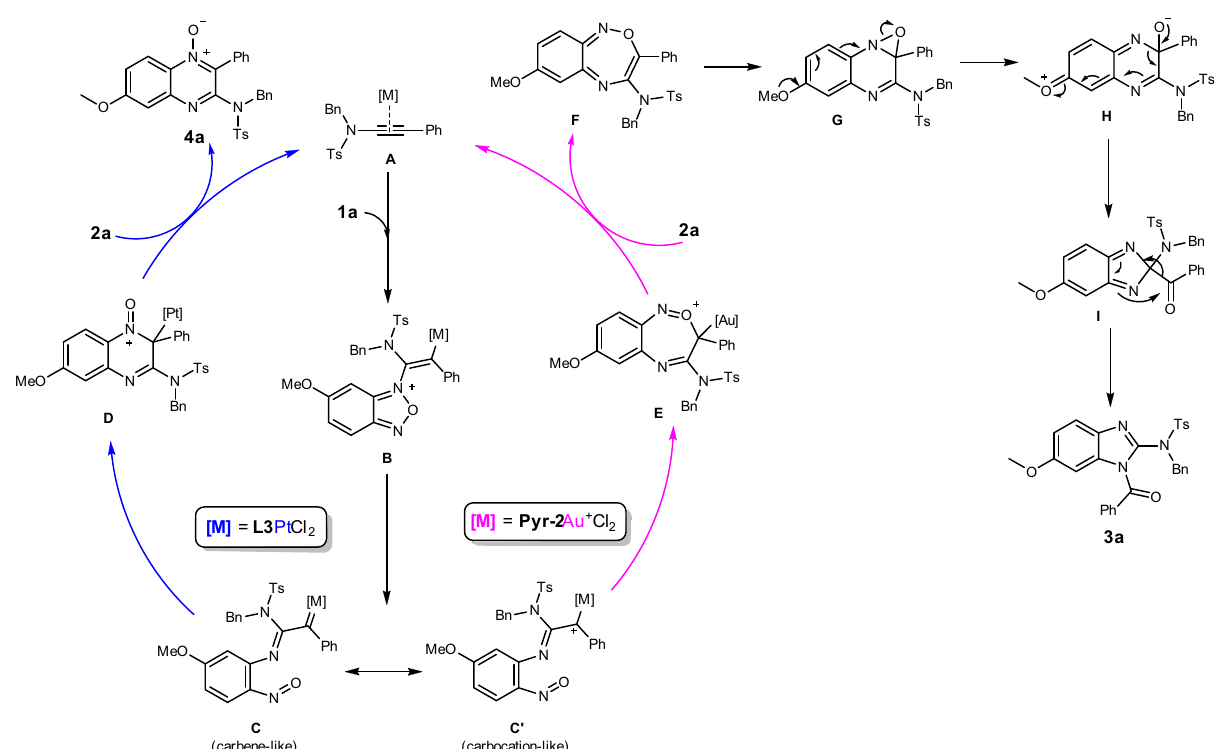
Fig. 7 Proposed reaction mechanism for Au(III) and Pt(II) systems. The difference between gold(III) and platinum(II)